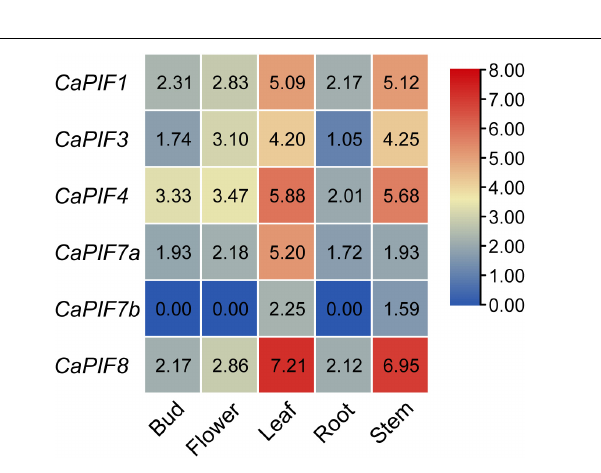
both TRV2:CaPIF8 and TRV2:00 plants, and the